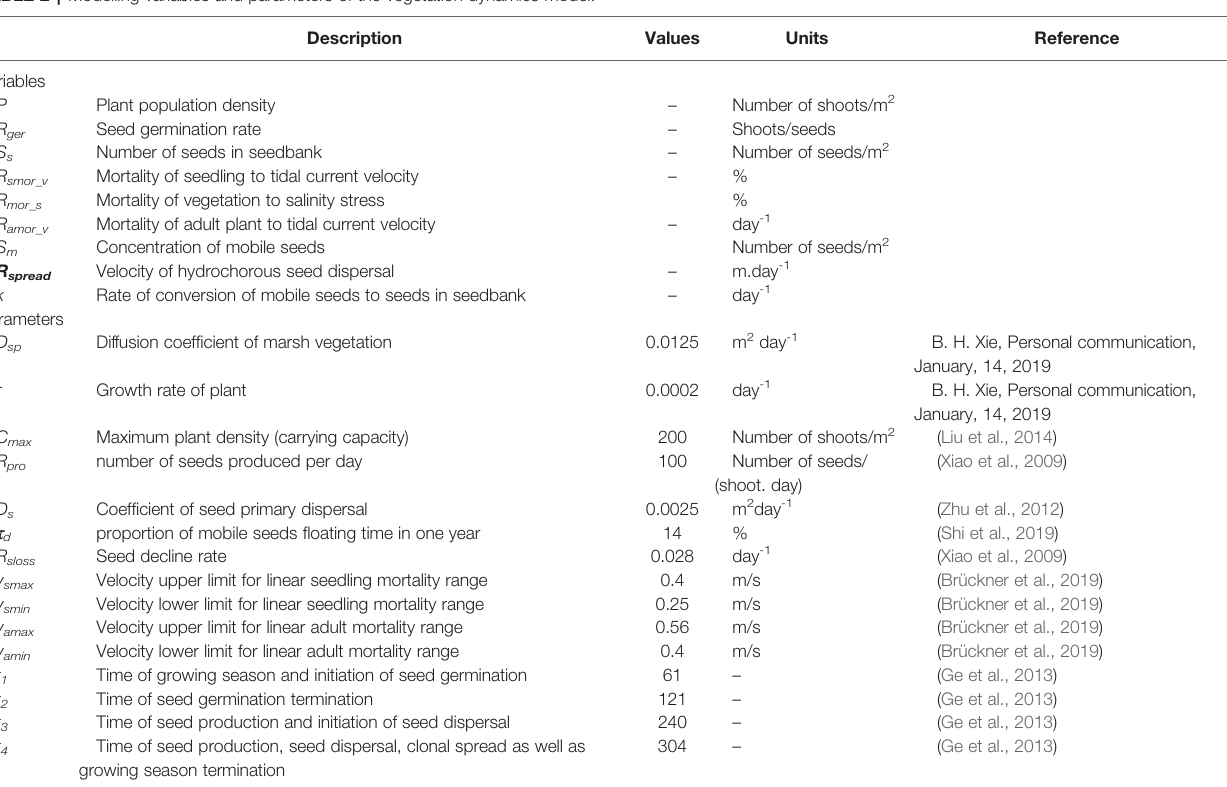
TABLE 2 | Modelling variables and parameters of the vegetation dynamics